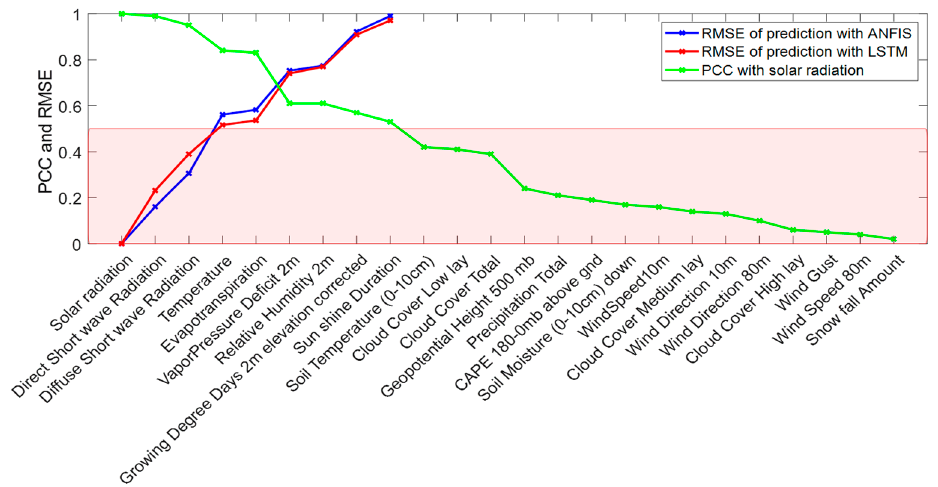
Figure 11. Winter season ranking between different meteorological parameters based on Pearson Correlation Coefficients and comparative performance of LSTM and ANFIS models with significant parameters selection (PCC ≥ 0.5) (dataset from 22 December 2020 to 20 March